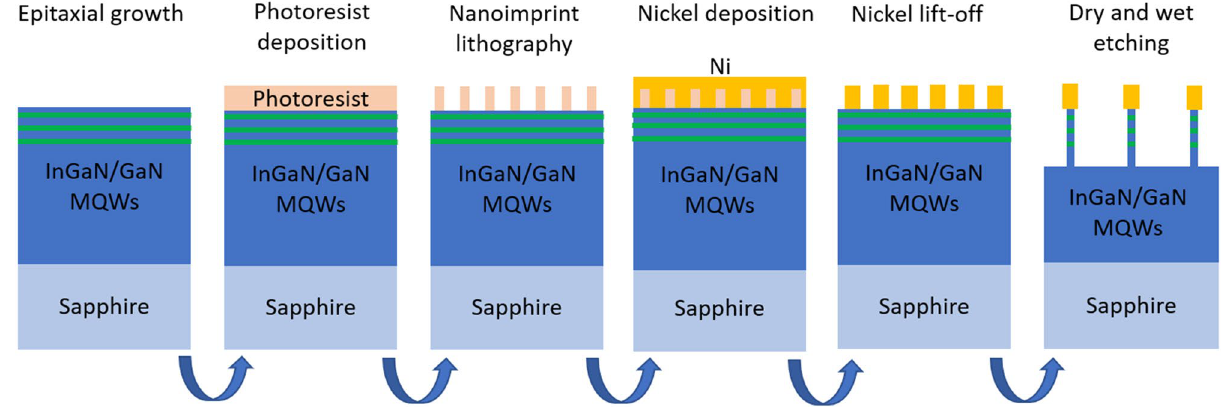
Figure 8. Flowchart of the nanofabrication of GaN NRds with axial InGaN/GaN MQWs by nanoimprint lithography and a mixed dry ICP wet etching